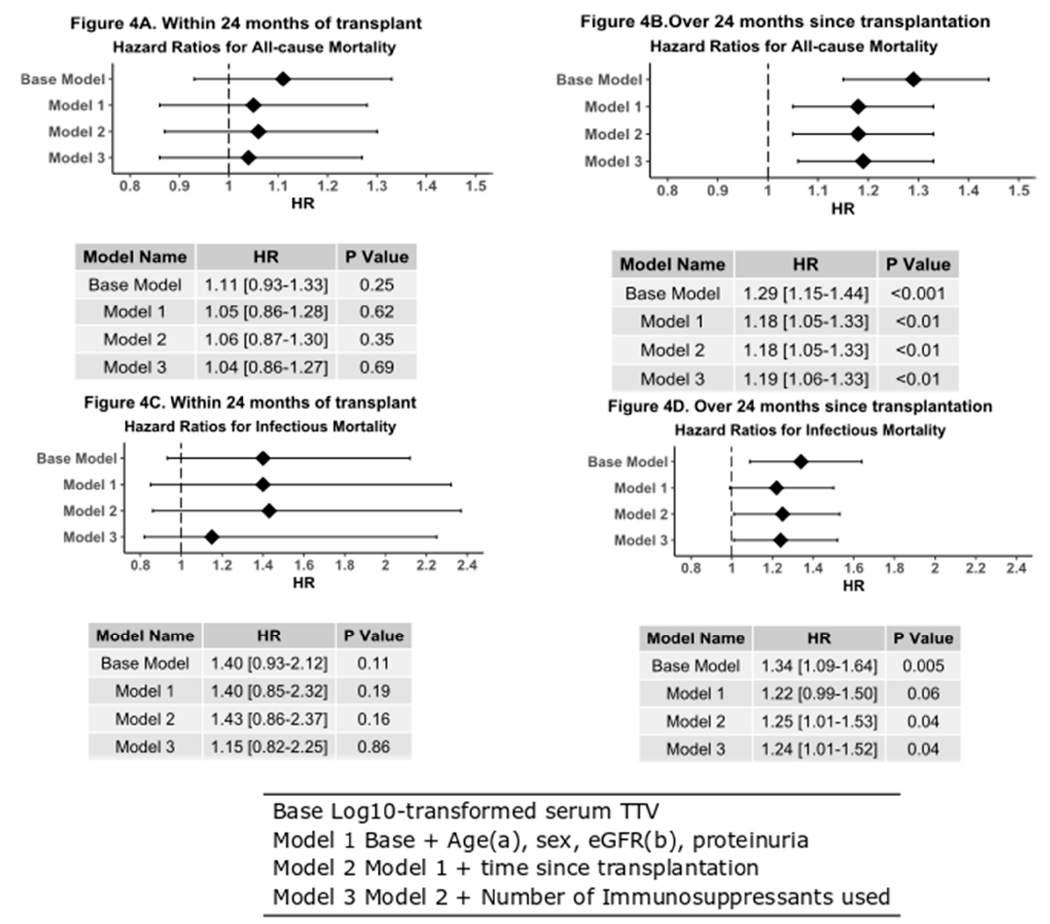
Figure 4. Forest plots with hazard table of Cox models after adjustment for age, gender, eGFR proteinuria, and the number of immunosuppressant’s used. ( A ) All-cause mortality in patients transplanted within 24 months of TTV analysis; this includes 31 events. Log 10 TTV cannot be used to predict risk of death transplanted within 24 months of TTV analysis. ( B ) All-cause mortality in patients tested over 24 months after transplantation, this includes 110 events. Log 10 TTV is highly predictive of the risk of death for patients with elevated TTV (HR 1.19 (95%CI 1.06–1.33), p < 0.01). ( C ) Log 10 TTV is not predictive of death due to an infectious cause in patients tested over 24 months since transplantation (HR 1.15 (95% CI 0.82–2.25), p = 0.86). ( D ) Log 10 TTV is predictive of death due to an infectious cause in patients 24 months after transplantation (HR 1.24 (95%CI 1.01–1.52), p = 0.04). a Categorical variable used for death due to an infectious cause. b Categorical variable used for all-cause